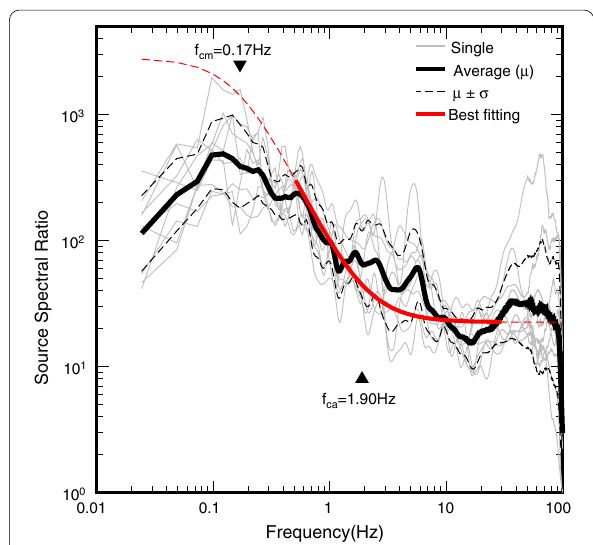
Fig. 2 Fitting of the average observed source spectral ratio (thick curve). Gray curves show the observed source spectral ratios at the strong motion stations. Dashed curves show the standard deviation above and beneath the average observed source spectral ratios. The red curve shows the best-fitting theoretical source spectral ratio in the frequency range of 0.50 ~ 30.0